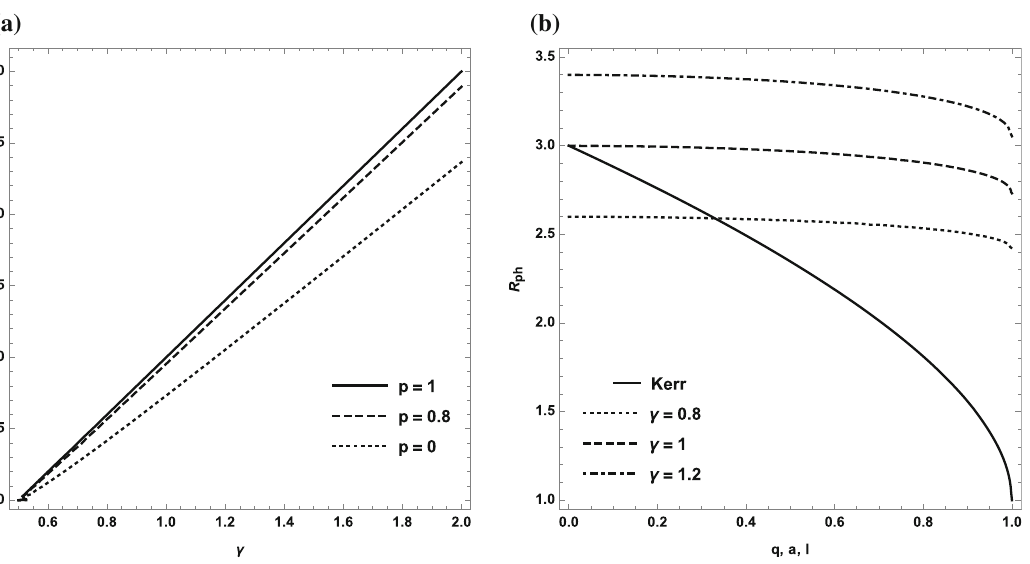
Fig. 6 Photon capture orbits in the stationary ZV space-time. Left panel: The dependence of the photon sphere radius on the deforma- tion parameter γ for different values of q . Right panel: The dependence of the photon sphere radius on the ‘quasi-NUT’ parameter q for differ-